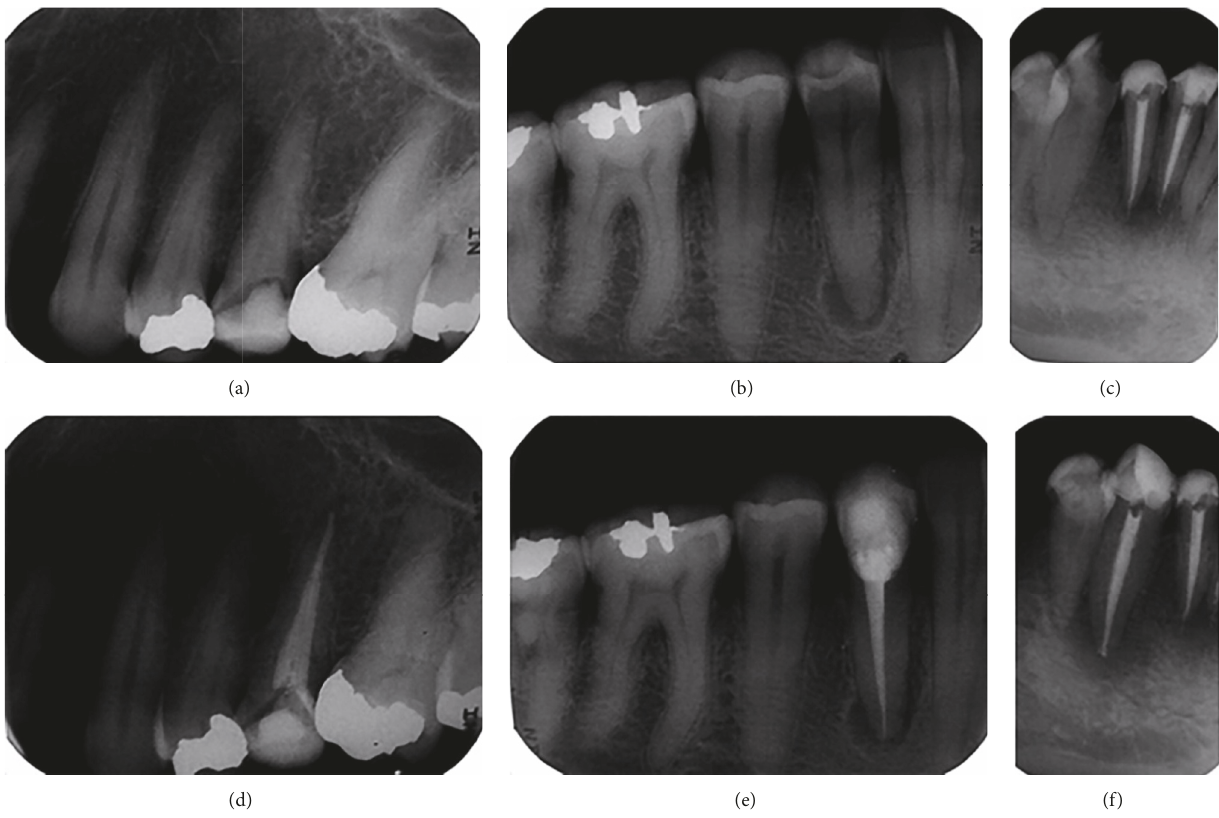
Figure 2: Digitized images of preoperative (a, b, c) and postoperative (d, e, f) conventional periapical radiographs using the MD300 USB X-ray Reader.